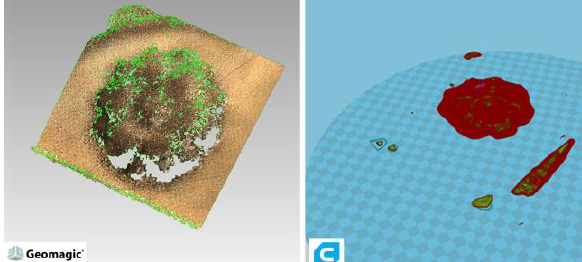
Figure 12. Creating mesh into Geomagic Wrap and check into CURA, the software for the 3D printing.